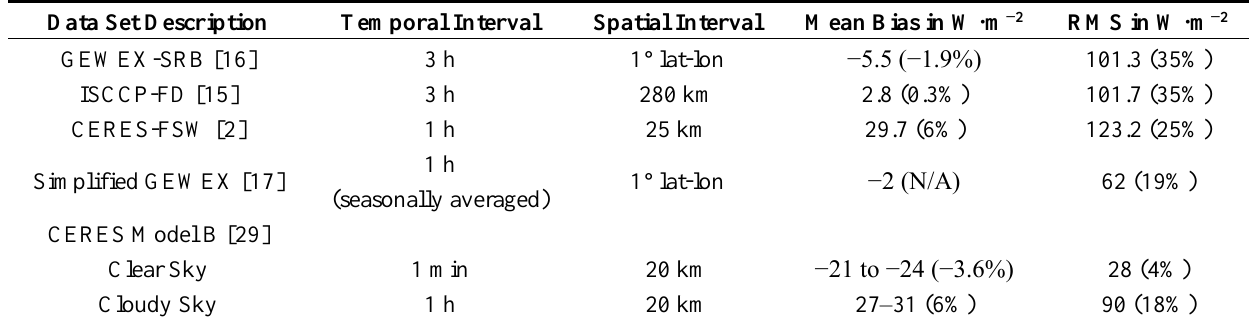
Table 4. Summary of error statistics for downward SW flux derived from other studies. The data set name and its source are indicated in the first